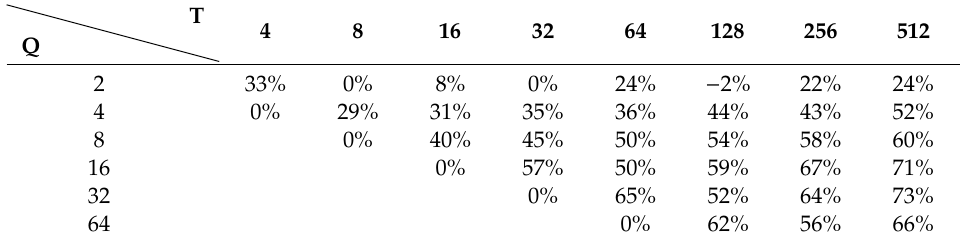
Table 2. Reduction in quiz length necessary to achieve 95% accuracy conferred by using UCB algorithm with optimal exploration constant over traditional random question approach. All numbers are given for the optimal C value, where T—number of topics; Q—total number of questions. Green color indicates large reduction in quiz length, and red indicates lesser benefit.